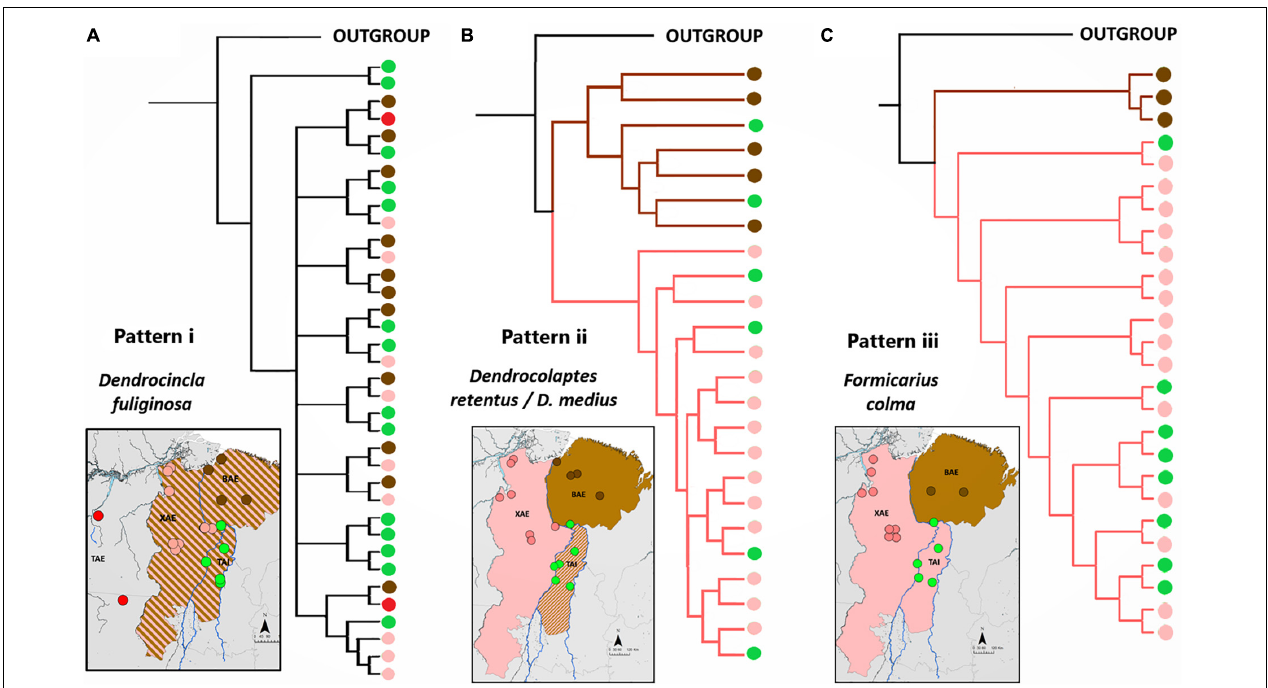
FIGURE 3 | Topologies of phylogenetic trees representative of each of the three phylogeographic patterns recovered among lineages of the sampled taxa inhabiting the XAE, BAE, and TAI. Black circles represent outgroup samples, whereas red, green, pink, and brown circles refer respectively to the TAE, TAI, XAE, and BAE samples. (A) Phylogenetic tree obtained for Dendrocincla fuliginosa illustrating pattern i (null hypothesis), whereby no geographically structured was recovered. (B) Phylogenetic tree of samples of the allopatric Dendrocolaptes retentus (whose distribution is centered in the XAE) and D. medius (distributed mainly in the BAE) illustrating pattern ii, in which the riverine barrier effect is present only in the lower Tocantins River, with the TAI consisting a contact zone between otherwise allopatric lineages replacing each other in the XAE and BAE. (C) Phylogenetic tree recovered for Formicarius colma samples illustrating pattern iii, in which the barrier effect is present along the entire Tocantins River, implying in a sister relationship between XAE and TAI lineages to the exclusion of those in the BAE. See Supplementary Material for details on these and the other sampled